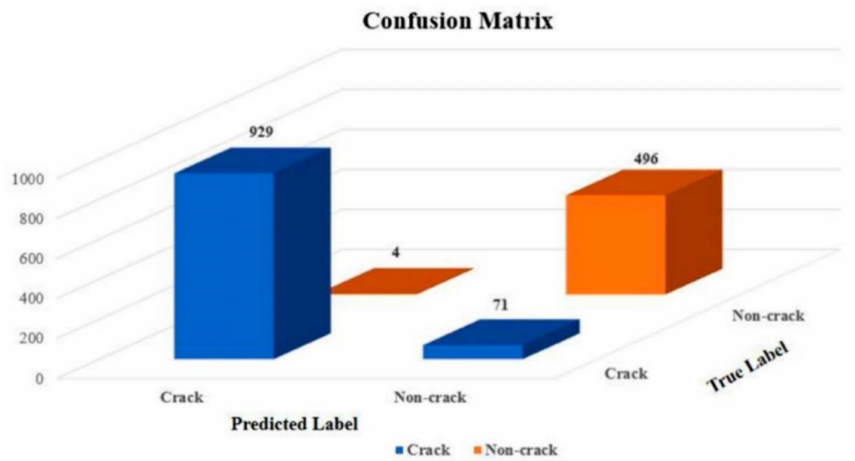
Figure 12. The confusion matrix of the Xception_71 test on the test dataset